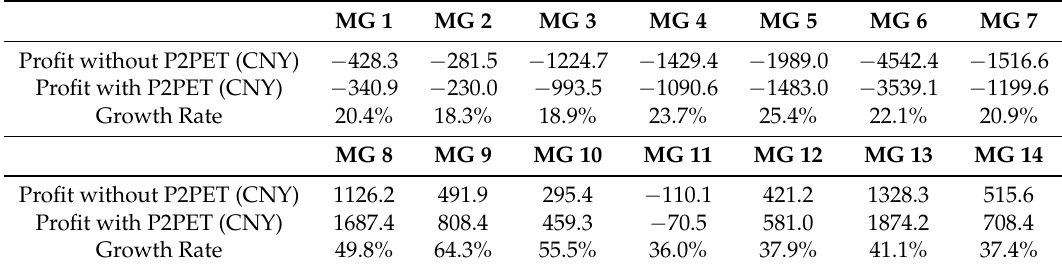
Table 3. Contrast of profits between two mechanisms of energy